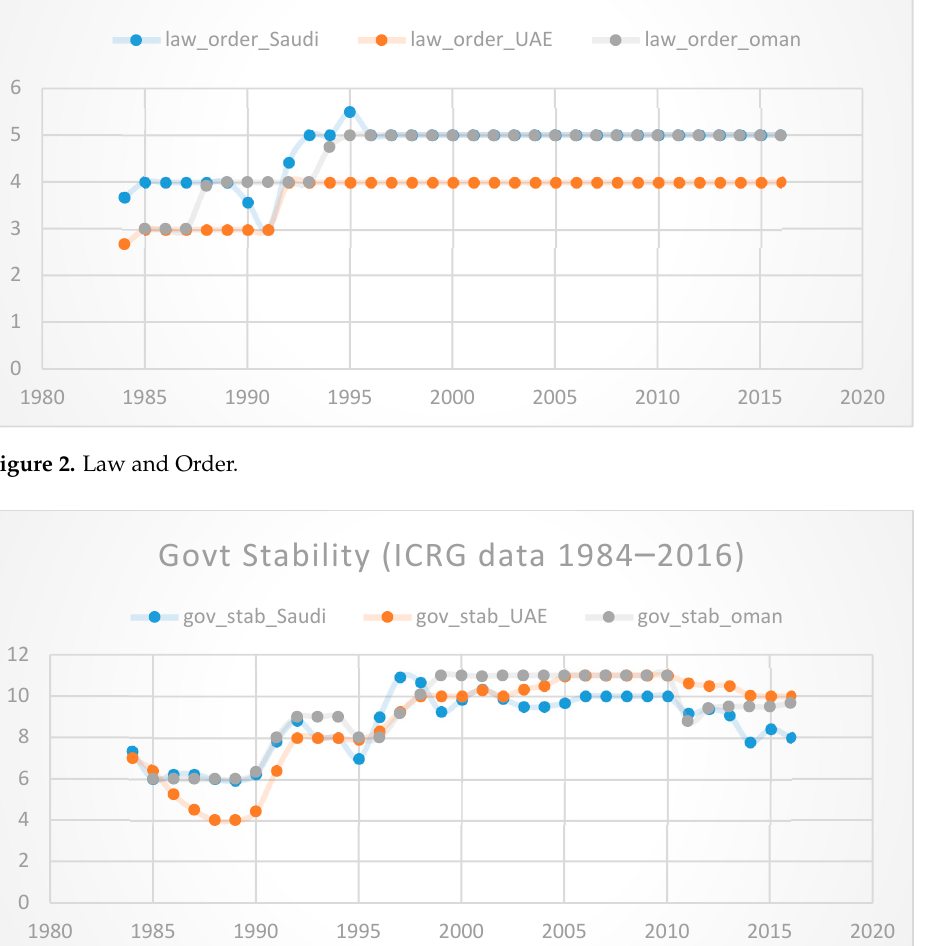
Figure 3. Government Stability.